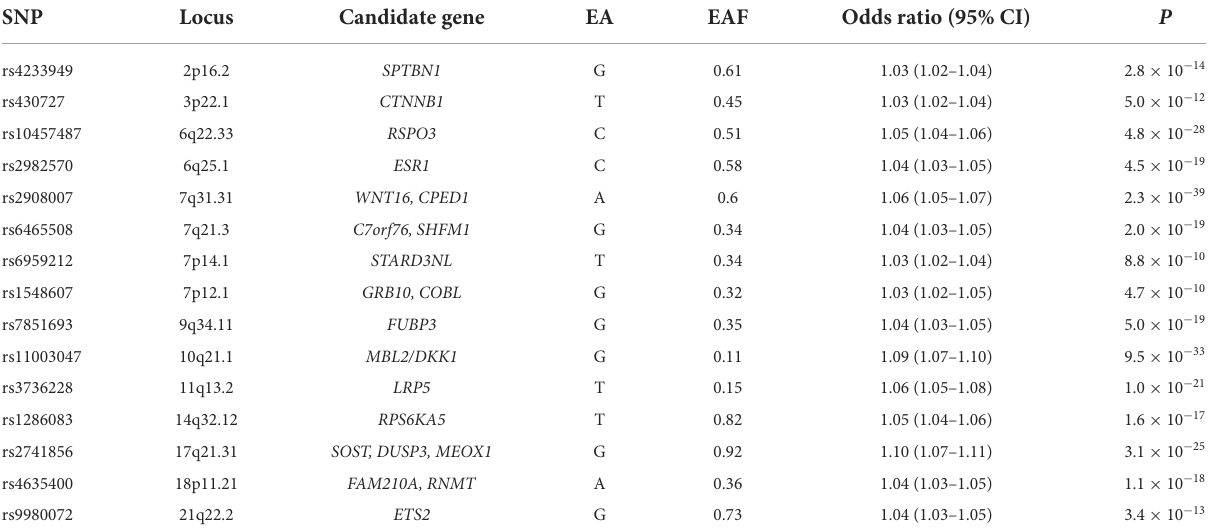
TABLE 2 Detailed information about 15 fracture genetic